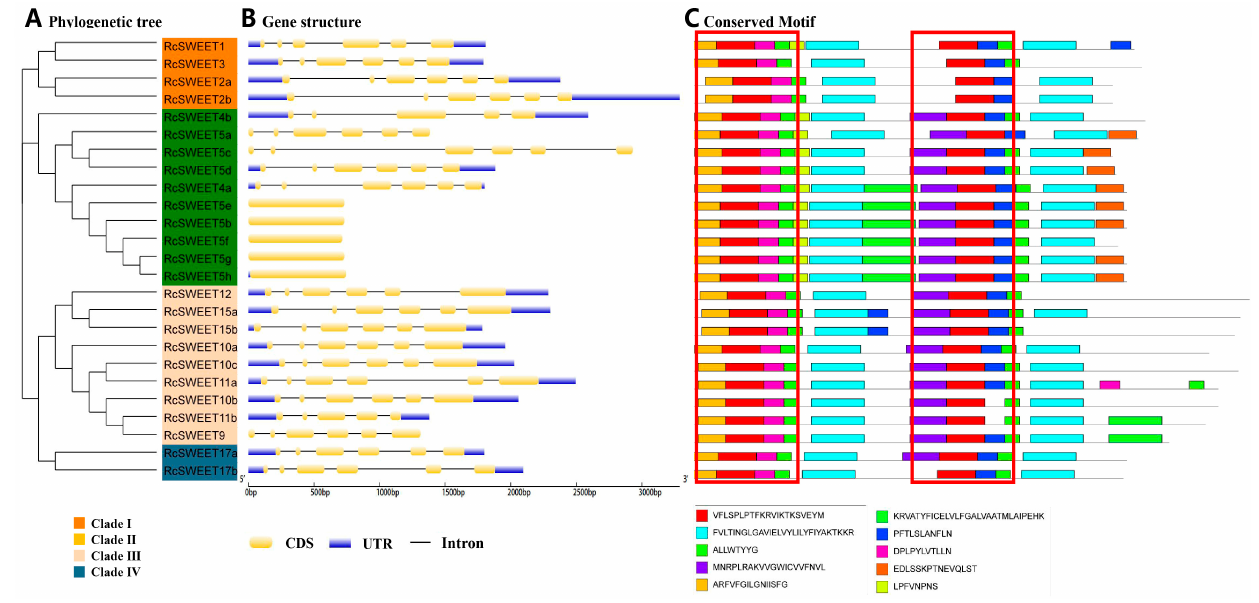
Figure 1. Phylogenetic relationship, gene structure, and conserved motif analysis of the RcSWEET genes. ( A ) Phylogenetic tree of 25 RcSWEET proteins. The unrooted neighbor-joining (NJ) phylogenetic tree was constructed with MEGA7 using amino acid sequences of 25 RcSWEET proteins, and the bootstrap test replicate was set at 1000 times. ( B ) Gene structure of RcSWEET genes. Yellow boxes represent CDS, and black lines represent introns. The upstream/downstream regions of the RcSWEET genes are indicated in blue boxes. ( C ) Distributions of conserved motifs in RcSWEET genes. Ten putative motifs are indicated in different colored boxes. The MtN3_slv domains were marked in two red frames.